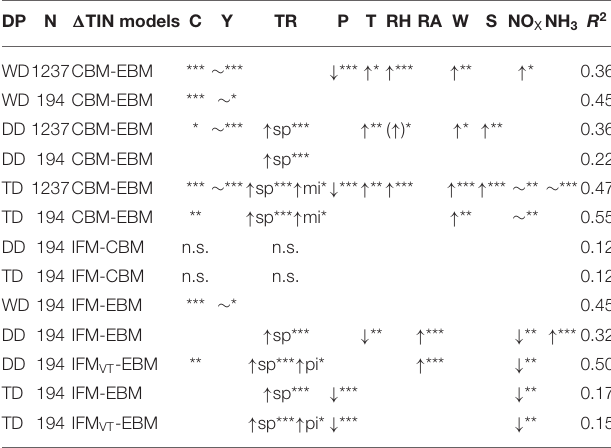
TABLE 7 | Significance and direction of the effects explaining differences between TIN deposition estimates for different deposition pathways (DP) and pairs of